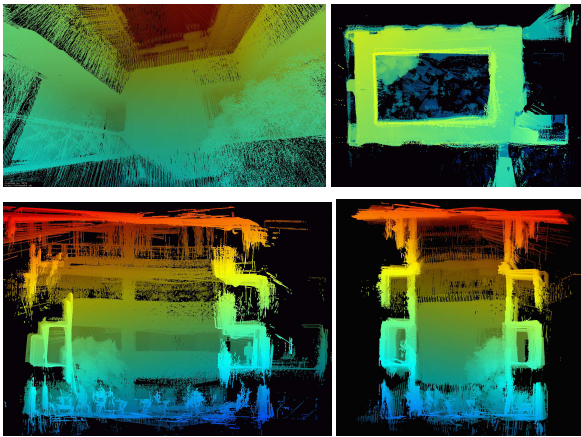
Figure 7. “unwound” 3D point cloud. Top left: 3D view. Top right: Bird eye view. Bottom: Side views.